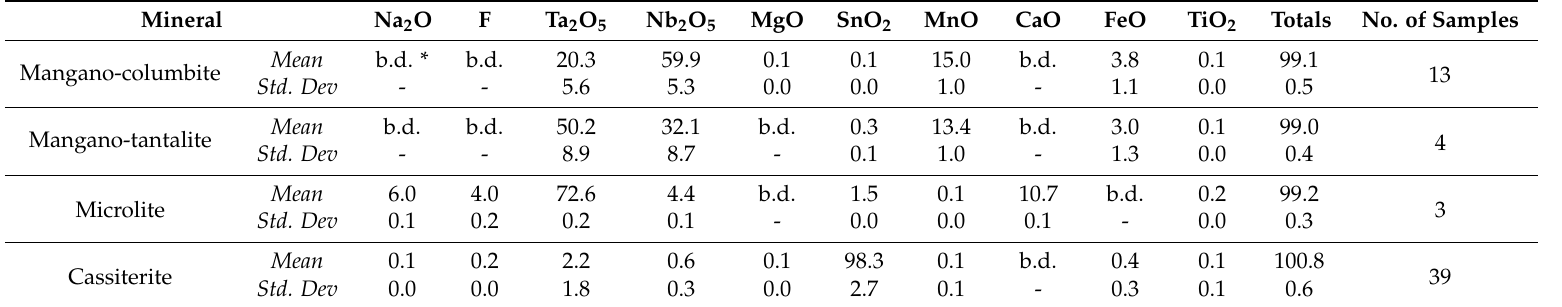
Table 6. Summary table of EPMA results for point analysis (wt